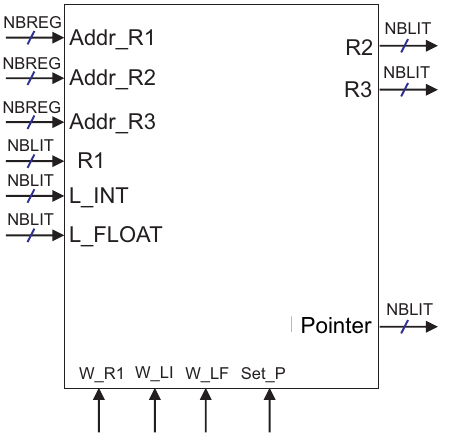
Figure 6. Logic block of the register bank for monocycle and pipeline